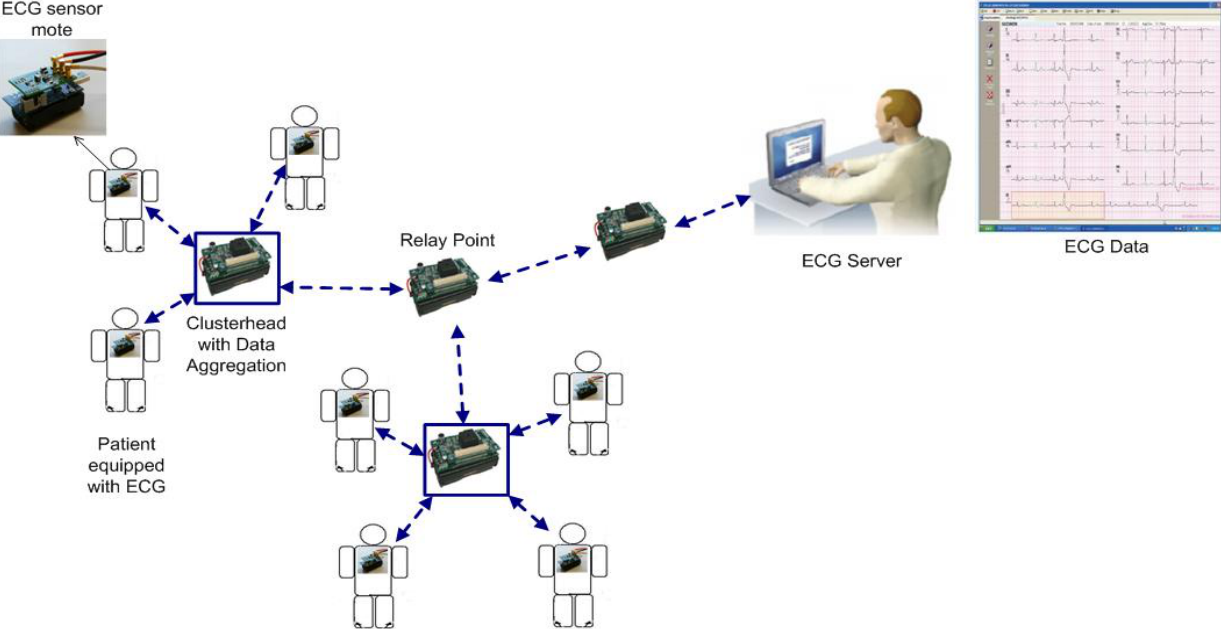
Figure 3. Overview of MASN architecture and